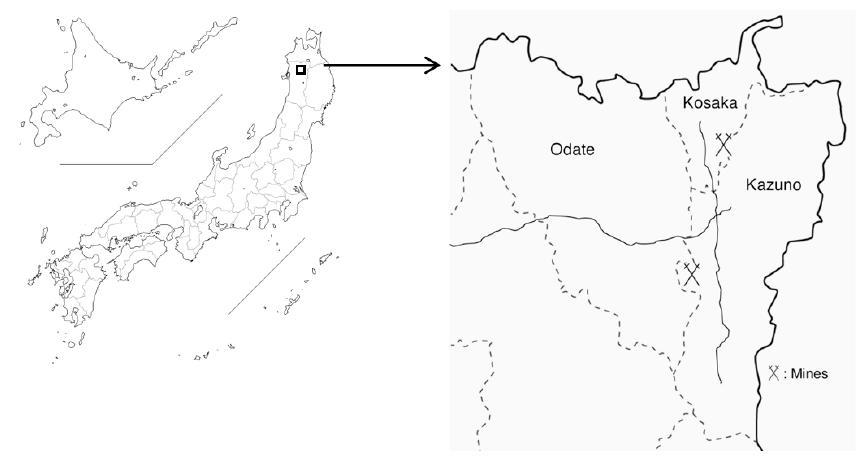
Figure 1. A map of area A (Odate city) and area B (Kazuno city and Kosaka town) in Akita, and their location in Japan (cited from CraftMAP). The thick solid line, dotted lines, and thin solid lines indicate the prefectural boundary, boundaries of municipalities, and courses of the river, respectively.